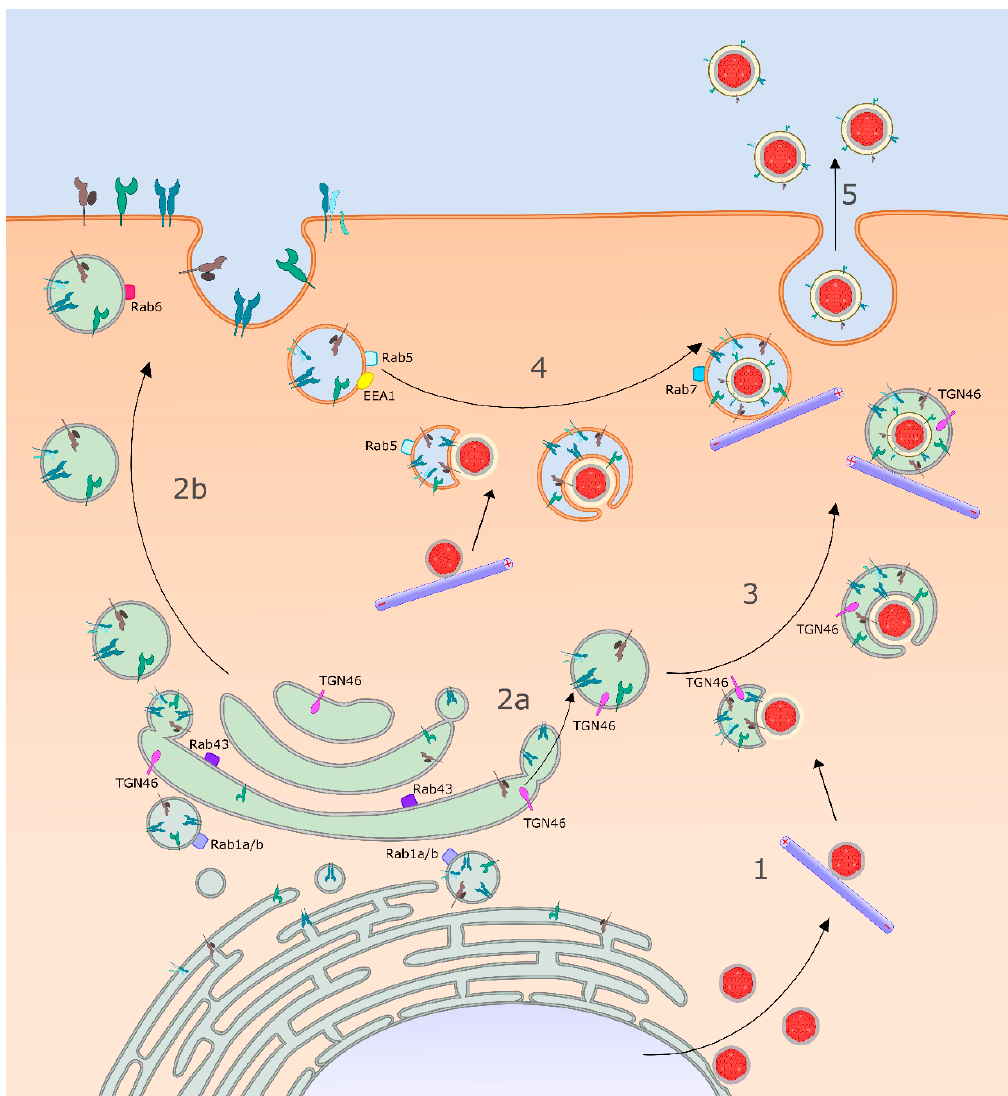
Figure 2. HSV-1 cytoplasmic envelopment and tra ffi cking. (1) HSV-1 capsids (red hexagons) emerge from the nucleus and inner tegument (gray layer) recruits kinesin for tra ffi c to the plus ends of MTs (purple cylinders with + and - ends indicated) and to sites of cytoplasmic envelopment. Meanwhile, viral envelope proteins are processed via the conventional secretory pathway and tra ffi c from the endoplasmic reticulum (ER) to the TGN (2a) and / or plasma membrane (2b). Rab1a / b (light purple squares) facilitate envelope protein export from the ER, while Rab43 (purple squares) supports transport through the Golgi apparatus and Rab6 (red square) is important for delivery of envelope proteins to the cell surface. (3) In one model HSV-1 capsids acquire their envelopes by attaching to, and budding into, the TGN or TGN-derived vesicles that contain the integral membrane protein TGN46 (violet lollipops). (4) Alternatively, cell-surface viral envelope proteins are endocytosed in a Rab5 (pale blue squares)-dependent manner into tubular–vesicular structures that provide the envelope. However, these tubular-vesicular structures lack the marker EEA1 (yellow oval) and thus are distinct from early endosomes. In other studies, egressing HSV-1 capsids have been observed to colocalize with early and late endosomes (Rab5- and Rab7-labeled, respectively). In all cases capsid envelopment is coupled to completion of the outer tegument (yellow layer around capsid) and incorporation of envelope proteins into the mature virion. (5) OEVs utilize MTs to deliver mature enveloped virions to the cell surface. See text for